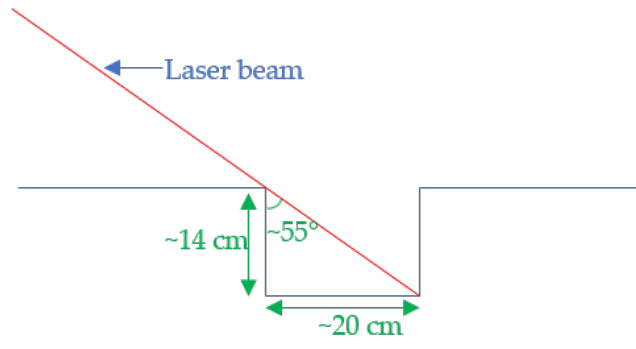
Figure 8. Limit of detection according to our disposition.